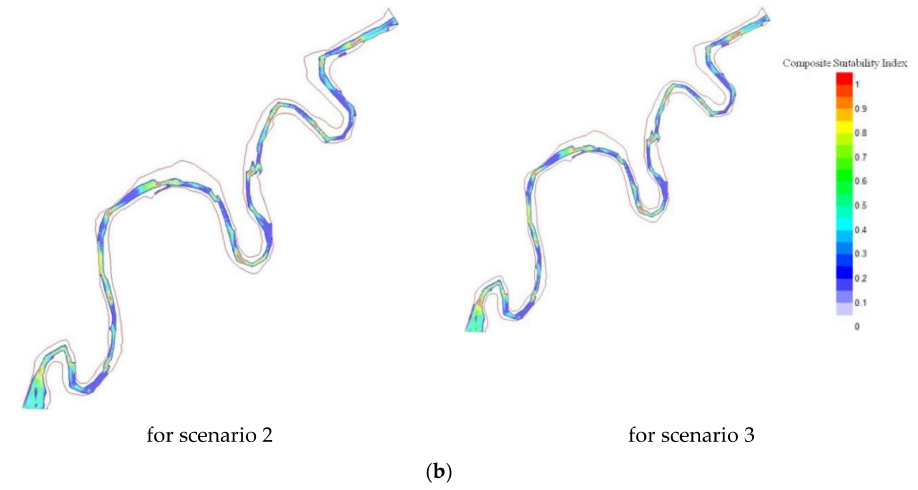
Figure 9. The distributions of the CSI for the target species: ( a ) Zacco platypus and ( b ) Baetis fuscatus .